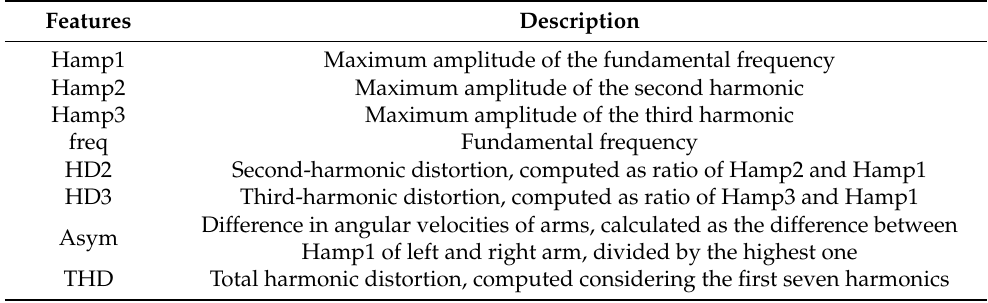
Table 2. Motor features of the harmonics in upper limb swings during gait.